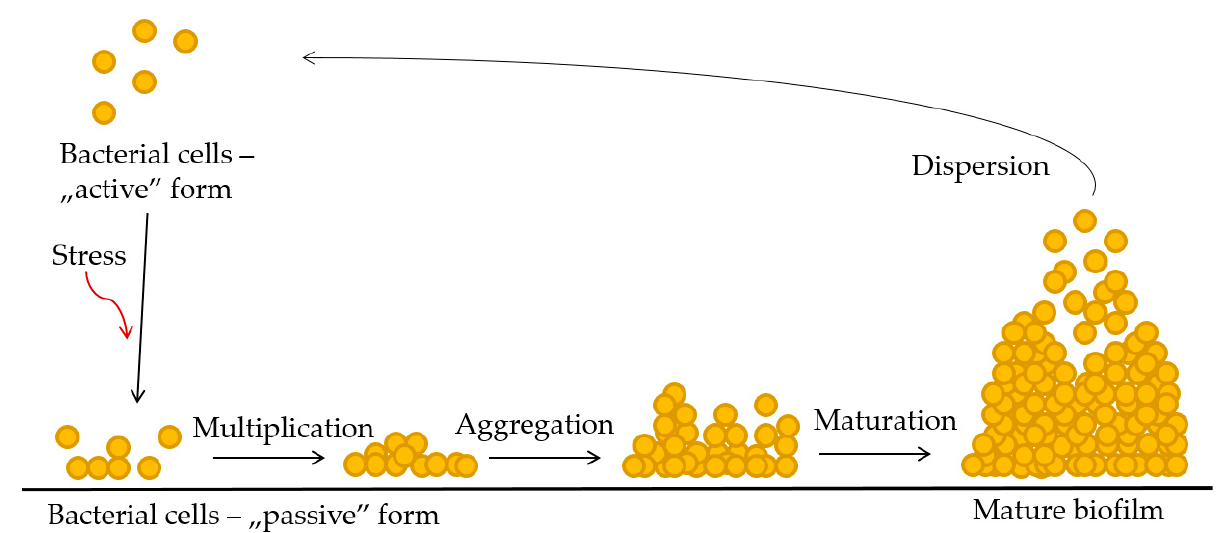
Figure 1. Stages of biofilm formation in staphylococci [4].